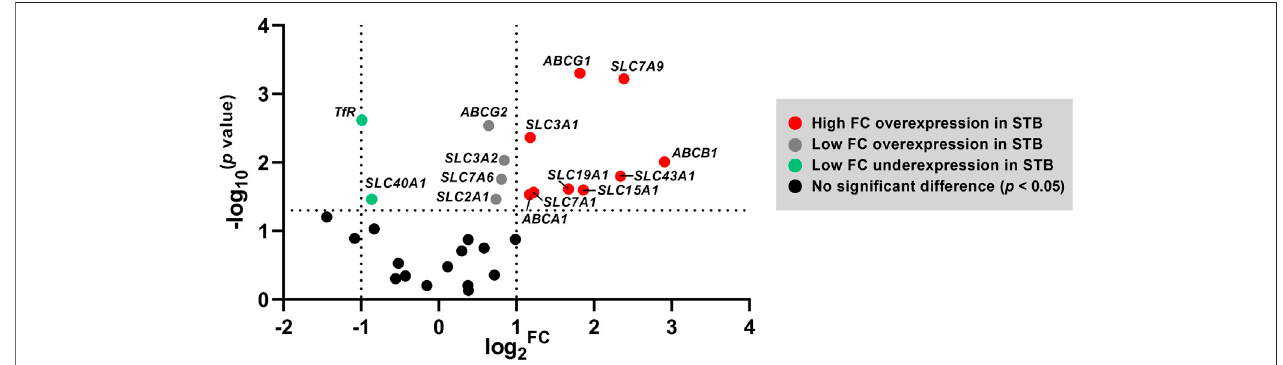
FIGURE3| VolcanoplothighlightingthesetofgenesthataredifferentiallyexpressedattheSTBstage.Thehorizontalaxisrepresentsmedianlog 2 foldchange(FC), and the vertical axis − log 10 transformed p values; statistical analysis was evaluated by nonparametric t-tests (Mann-Whitney test). The dotted lines represent the upper and lower limit of the threshold FC (which was set to 2) and the threshold p -value (set as <